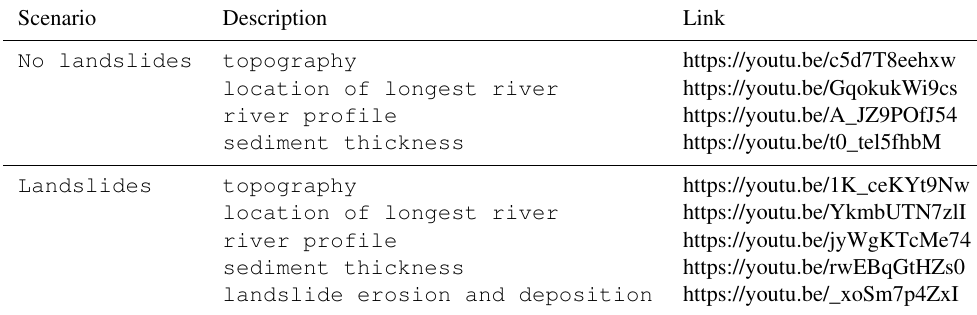
Table 4. Simulation movies created with Landlab-HyLands.